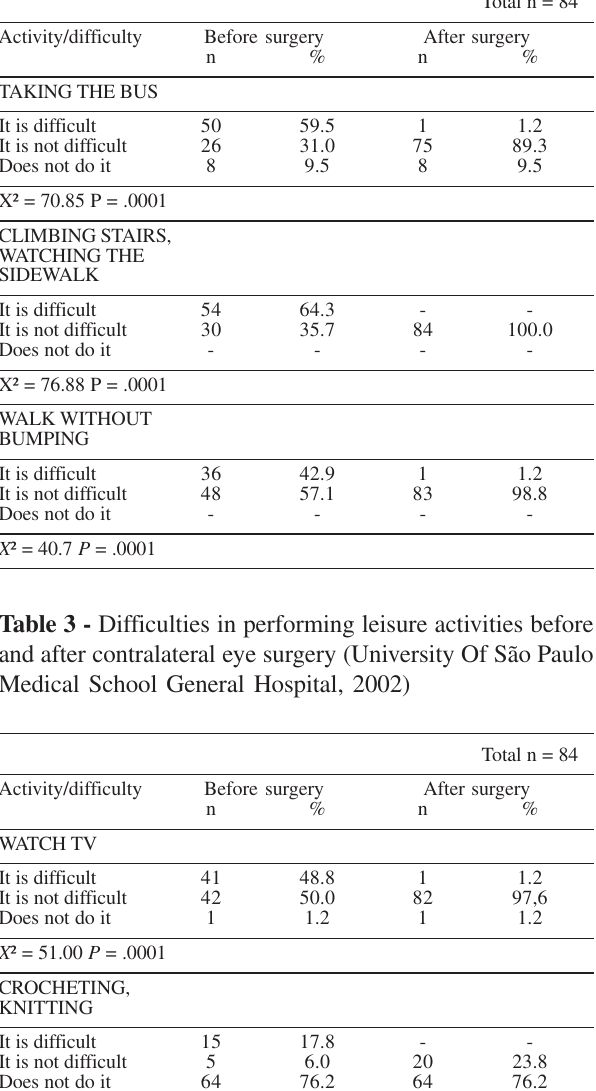
Table 2 - Difficulties in patient mobility before and after second eye surgery (University Of São Paulo Medical School